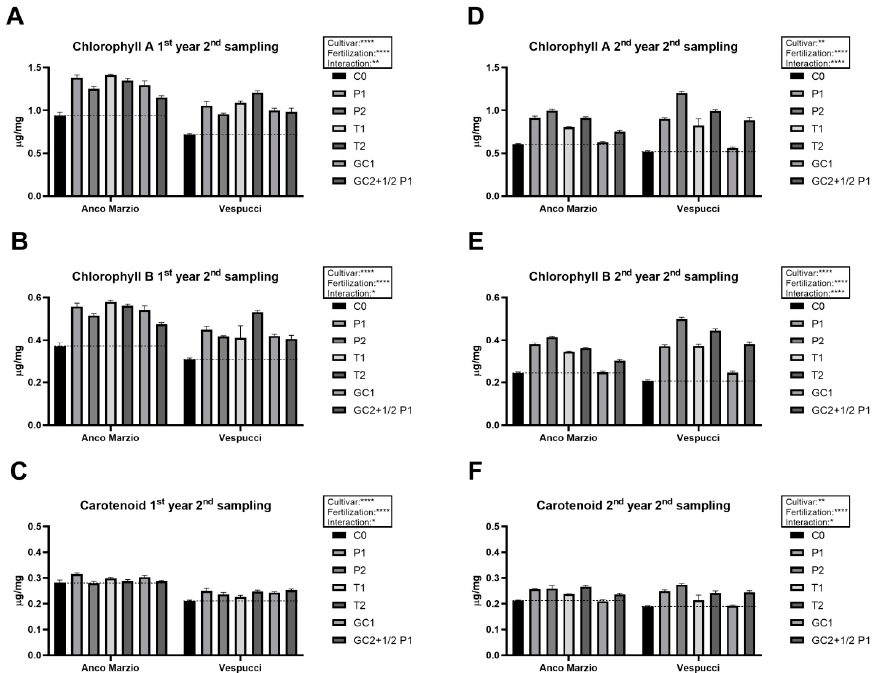
Figure 6. Pigment (Chlorophyll A, B, and Carotenoid) content on samples collected during the second crop stage (stem elongation). Data are related to the first ( A – C ) and second ( D – F ) year of analyses. Data were reported by indicating the statistical significance of two factors (Cultivar and Fertilization) and their interaction. Data are reported with p-values. * p ≤ 0.05; ** p ≤ 0.01; *** p ≤ 0.001; **** p ≤ 0.0001.